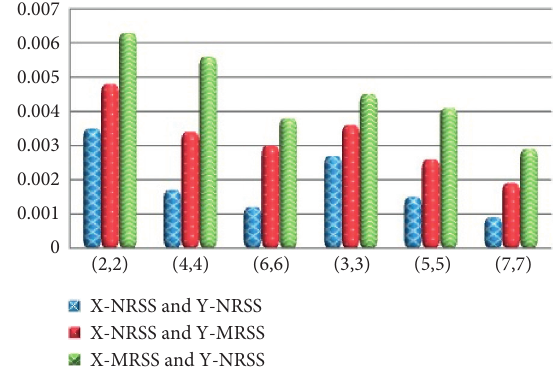
Figure 3: MSE of 􏽢 R at R � 0.925.